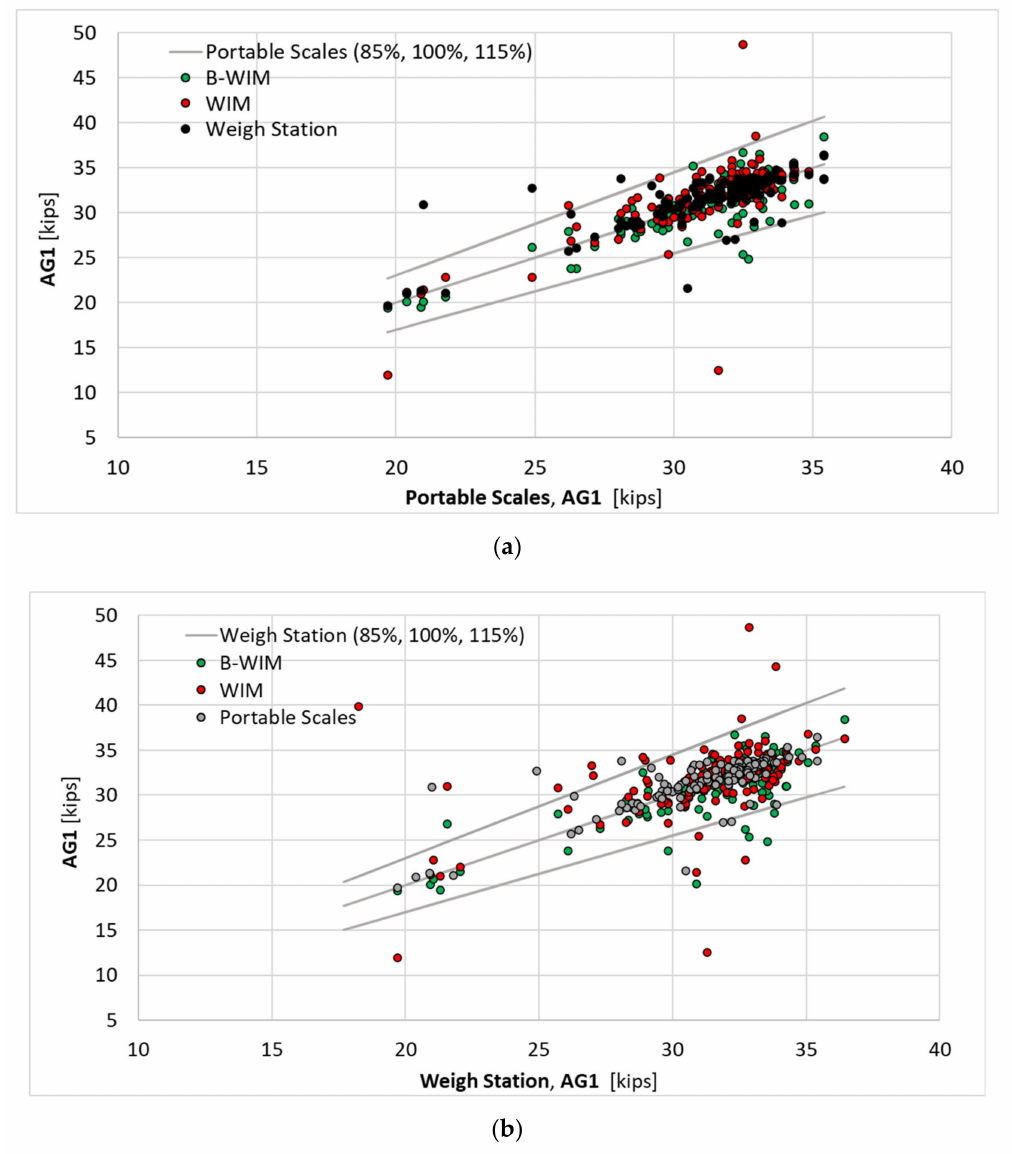
Figure 9. The first tandem axle weight measurement ( a ) compared to portable scales measurement, ( b ) compared to weigh station